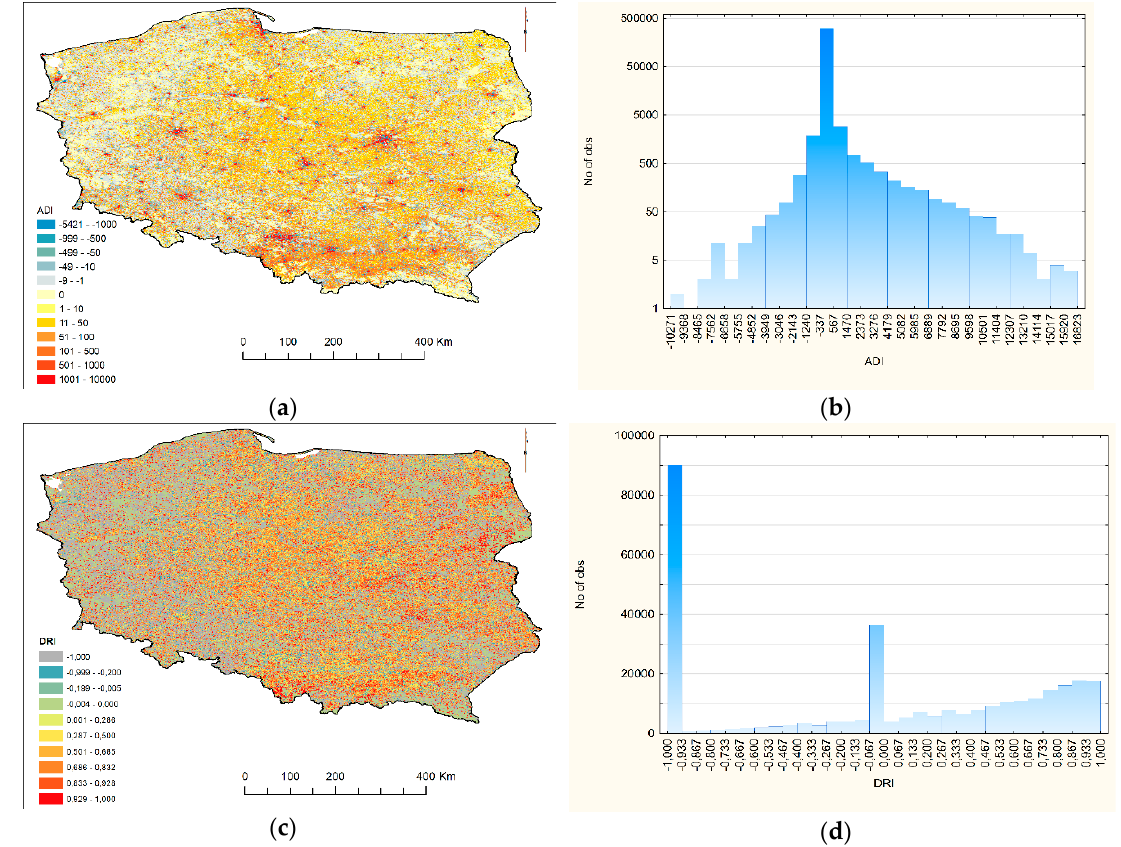
Figure 4. Disparity indices: ( a ) ADI—absolute disparity index; ( b ) histogram of ADI values, the number of grid cells (vertical axis) is presented in logarithmic scale; ( c ) DRI—deviation rate index; ( d ) histogram of DRI values.